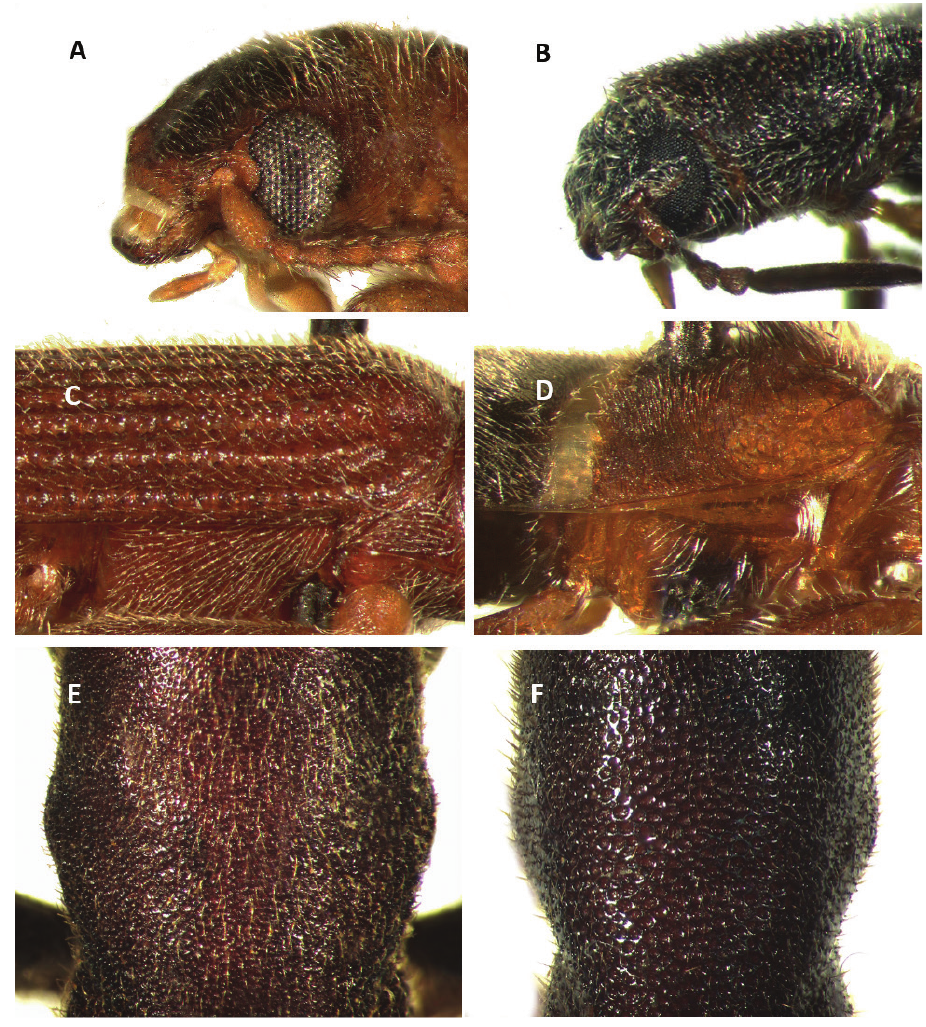
Figure 12. A–B Eye structure of: A Cymatodera laevicollis B Monophylla californica C–D Mesepister- num: C Hidden throughout its length in Lecontella gnara D Visible throughout its length in Callotillus eburneocinctus E–F Pronotal surface of: E Lecontella brunnea F Lecontella gnara .